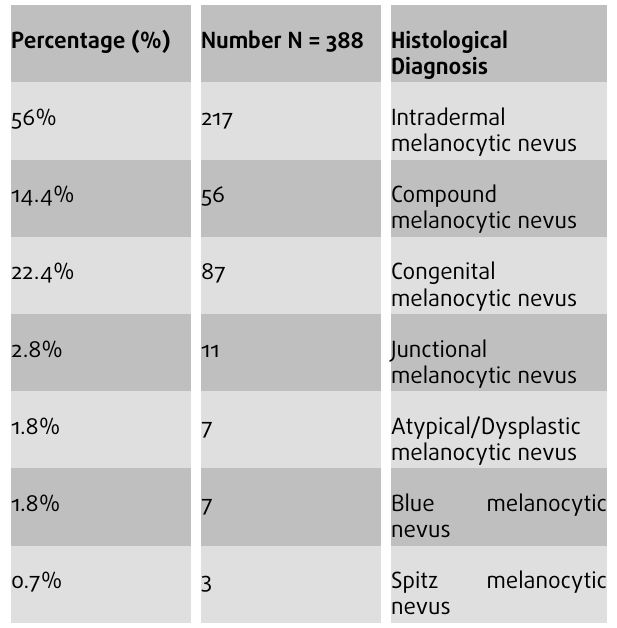
Table 4: Frequency of histopathological categories of MN among patients attending KAAUH between January 2000 and December 2017.